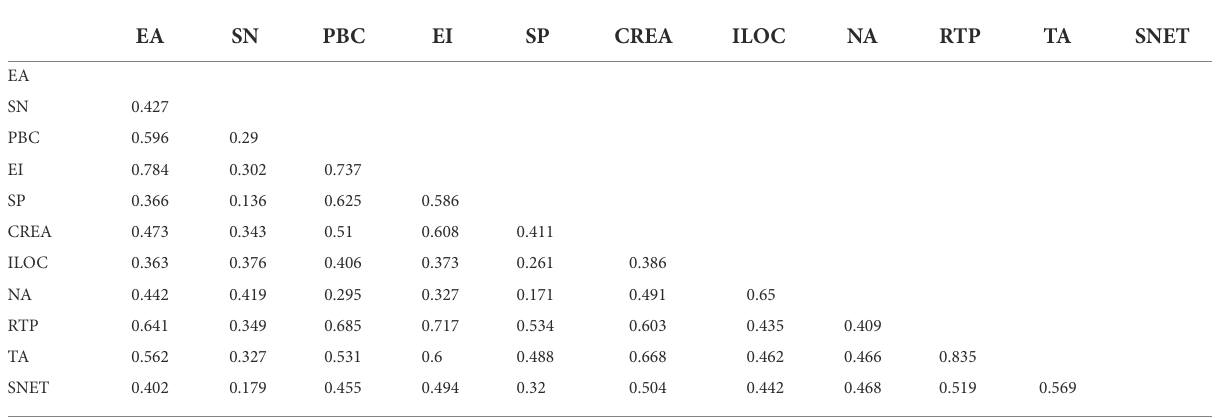
TABLE 7 Heterotrait-monotrait ratio